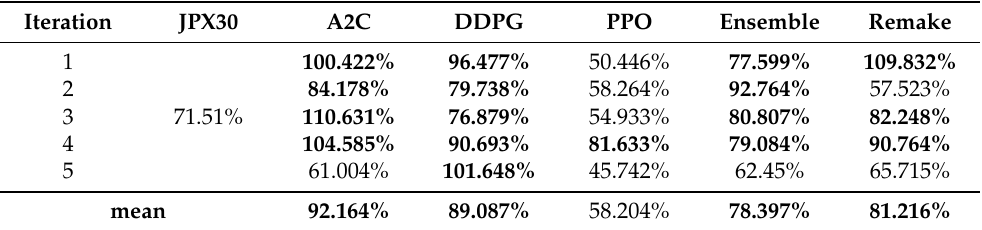
Table 6. Performance evaluation comparison for five agents after changing the trading strategy in